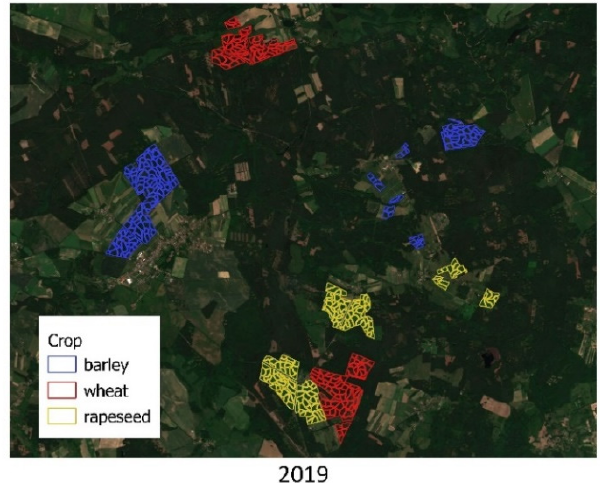
Figure 2. Fields included in the study with crops in subsequent years (2017–2019) . Table 1. Mineral fertilization (P, K, and Mg) applied for the studied crops. Crop Winter Wheat Winter Barley Winter Rapeseed 8 8